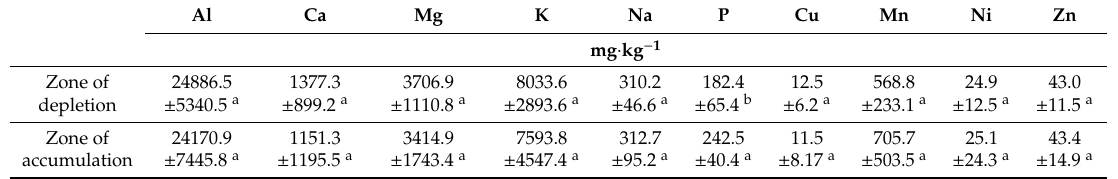
Table 2. Macro and microelements content in soil of depletion and accumulation